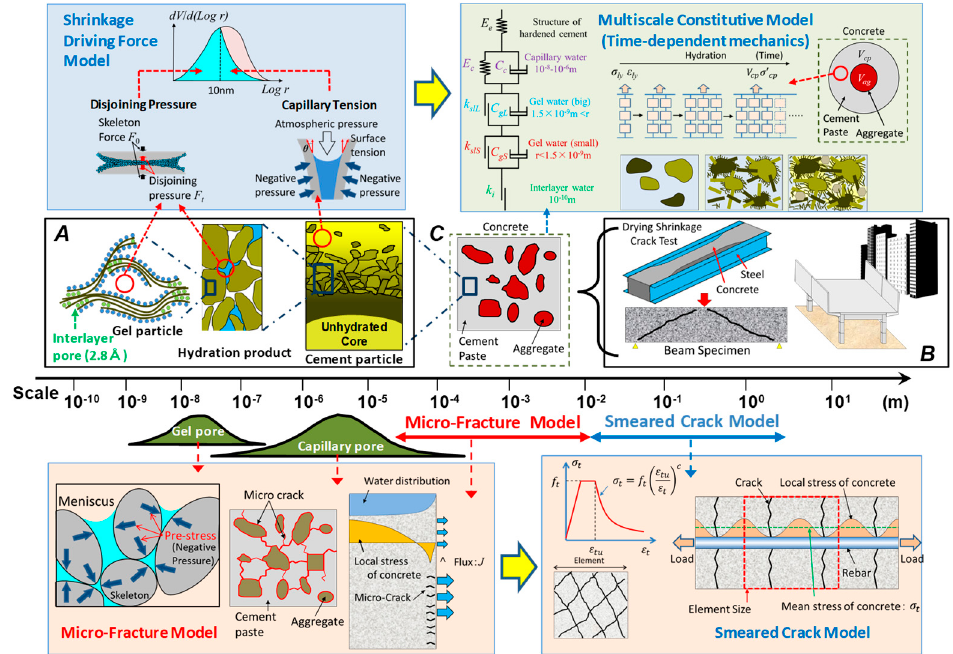
Figure 1. Scheme of the integrated multi-scale analysis system, Durability of Concrete Model (DuCOM)-COM3.